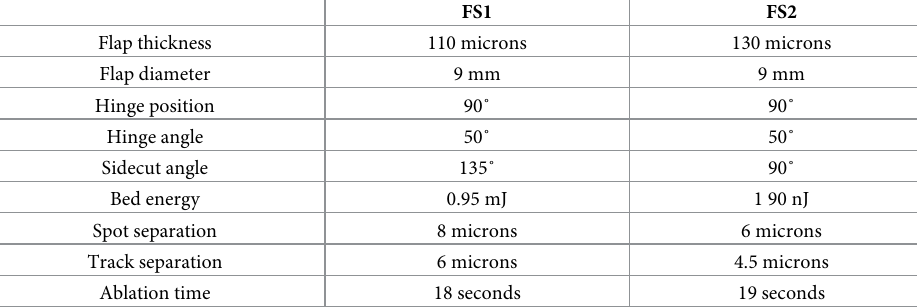
Table 1. LASIK photodisruption parameters for Intralase (FS1) and VisuMax (FS2). FS1 FS2 Flap thickness 110 microns 130 microns Flap diameter Hinge position Hinge angle Sidecut angle 135˚ 90˚ Bed energy 0.95 mJ Spot